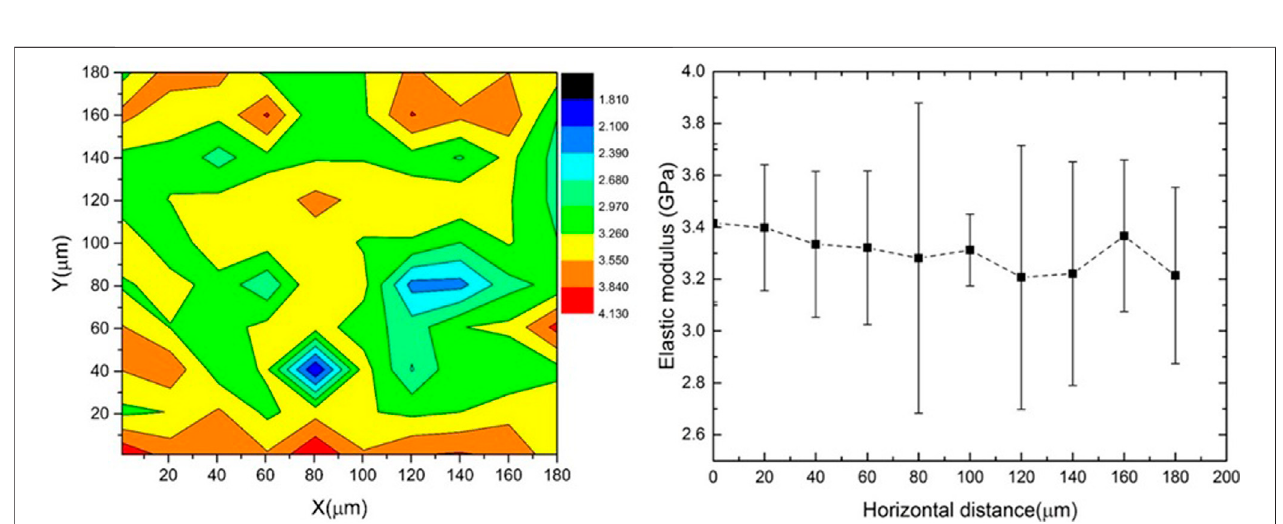
FIGURE 9 | (A) Modulus mapping on 180 × 180 micro m 2 area using nanoindentation (B) variation in modulus across horizontal